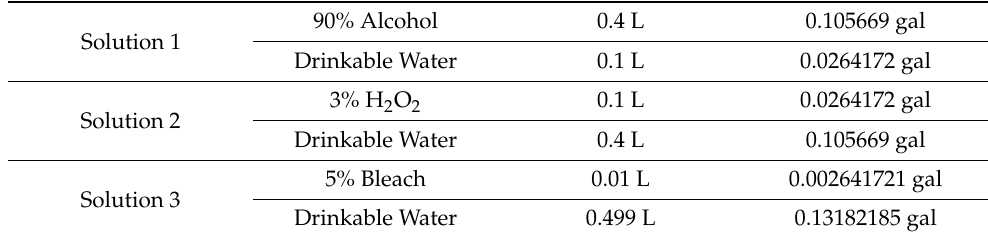
Table 1. Disinfectant recipes for